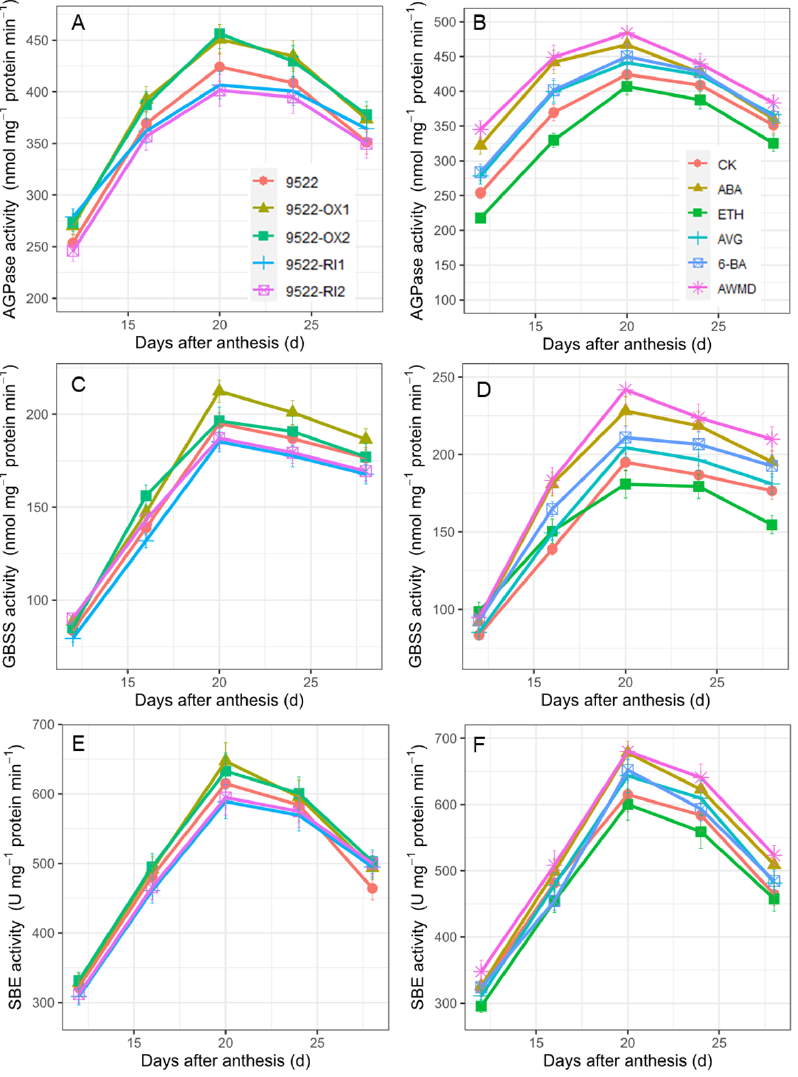
Figure 8. Activities of adenosine diphosphate-glucose pyrophosphorylase (AGPase; A , B ), granule-bound starch synthase (GBSS; C , D ), and starch branching enzyme (SBE; E , F ) in spikelets of rice of wildtype and transgenic lines ( A , C , E ), and application of exogenous phytohormone/alternate wetting and under moderate drying (AWMD) irrigation ( B , D , F ) during grain filling stage. Symbols and significance levels are as described in Figure 1.